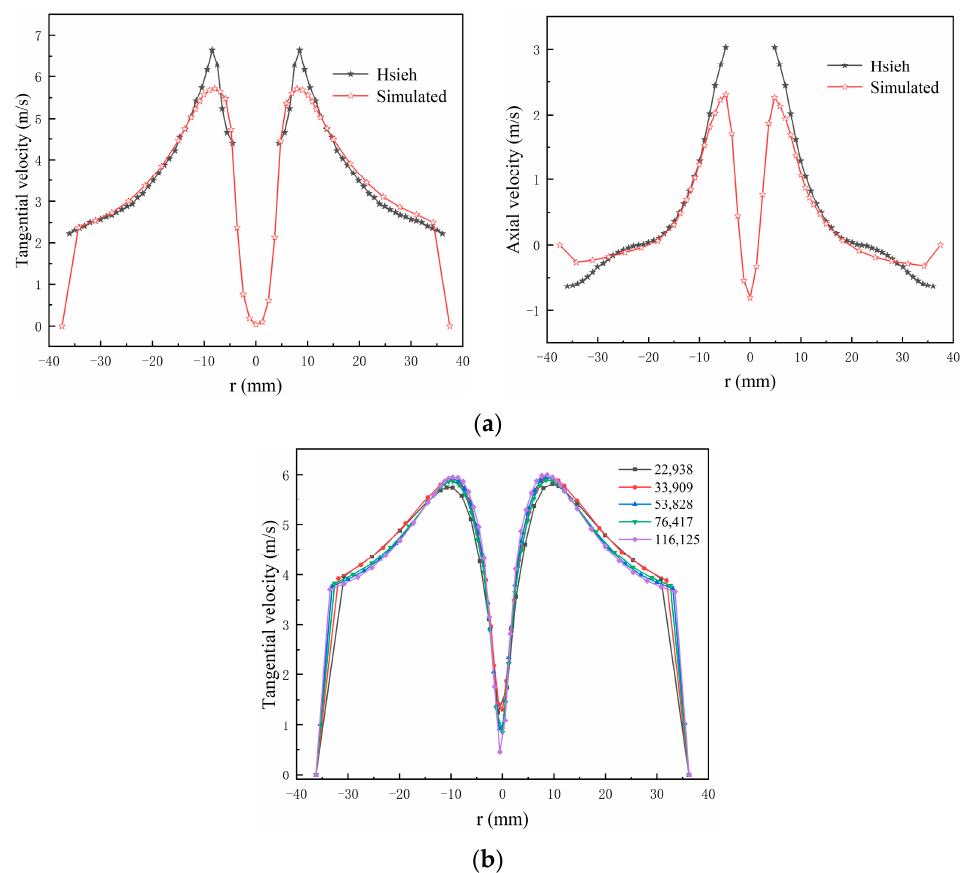
Figure 2. Independence verification of model and grid. ( a ) Independence verification of model; ( b ) Independence verification of grid .